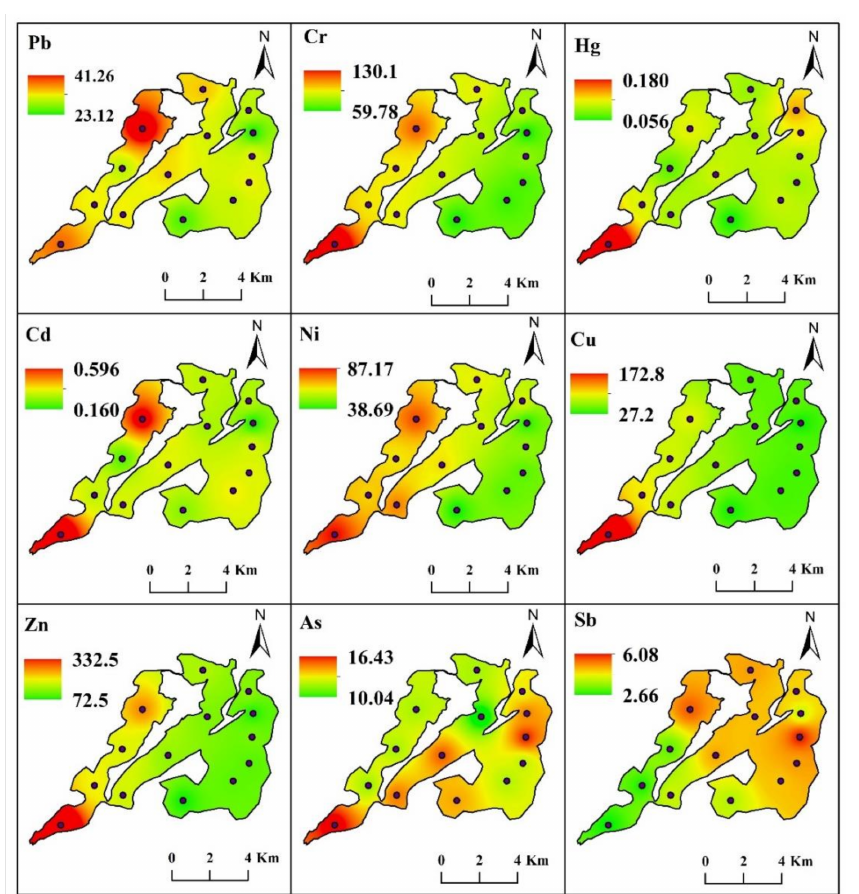
Figure 2. The spatial distributions of nine heavy metals were displayed according to the averages of four seasons in the lake sediment. The colored areas indicate the contents of heavy metals (unit: mg/kg) at the sampling sites. The color spectrum ranges from green (lowest) to red (highest).